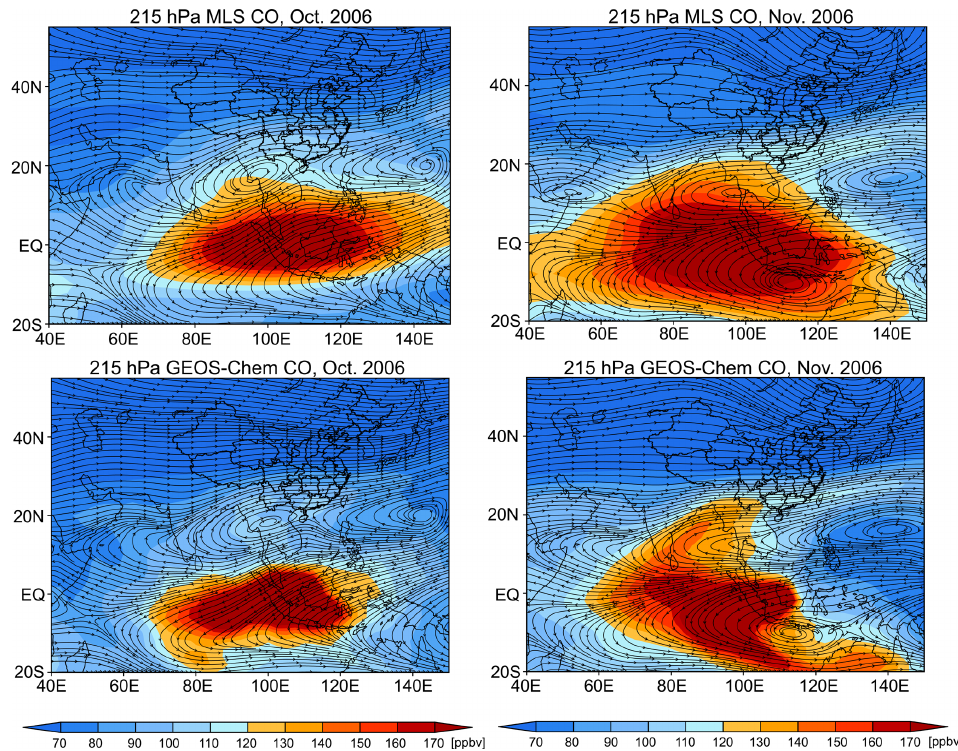
Fig. 7. MLS observed (top panels) and GEOS-Chem simulated (bottom panels) CO concentrations at 215hPa in October (left panels) and November (right panels) 2006. Also shown are streamlines from NCEP reanalysis data.